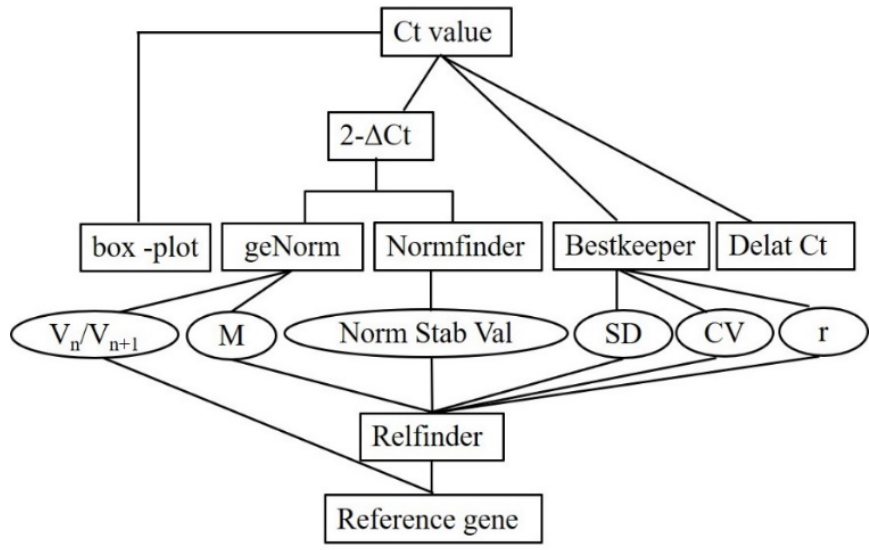
Figure 2. Data analysis flow chart.